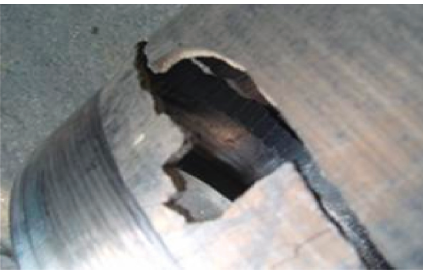
Figure 19: Spinning fracture defect.